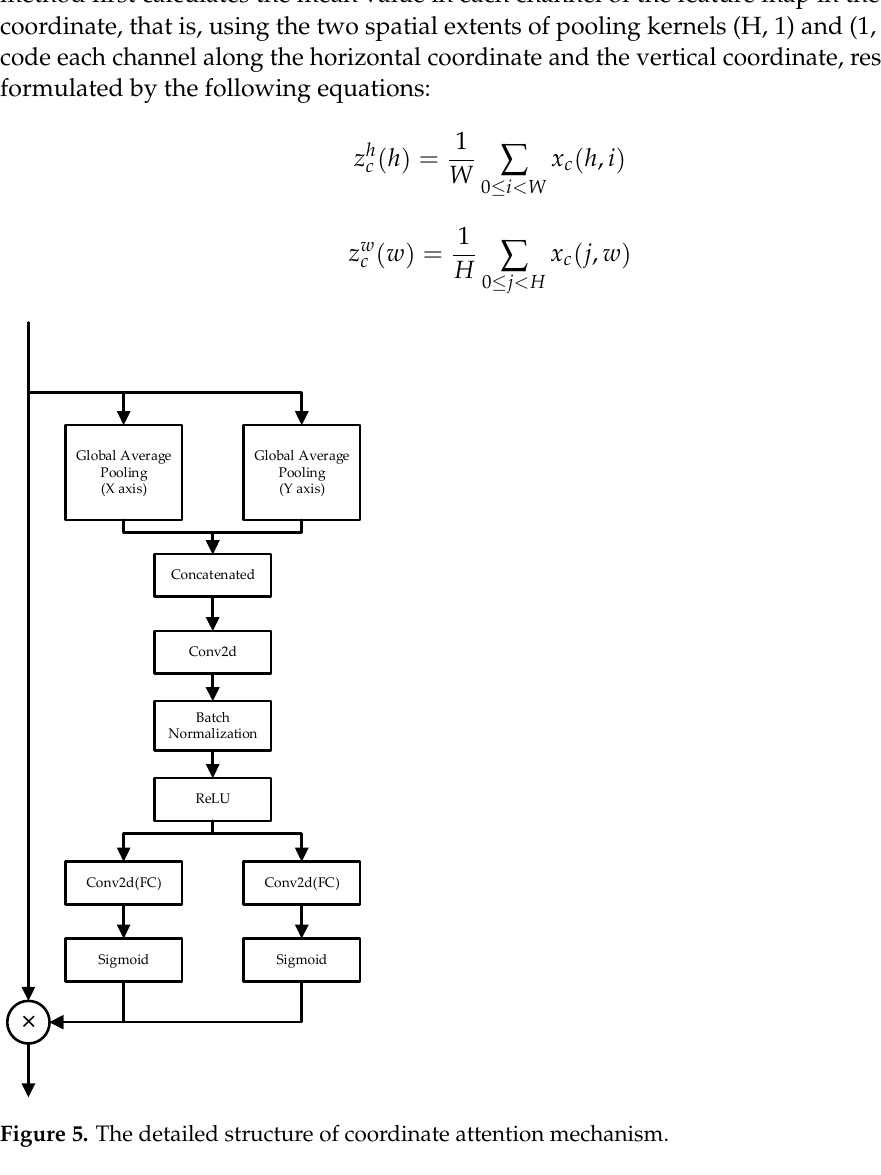
Figure 5. The detailed structure of coordinate attention